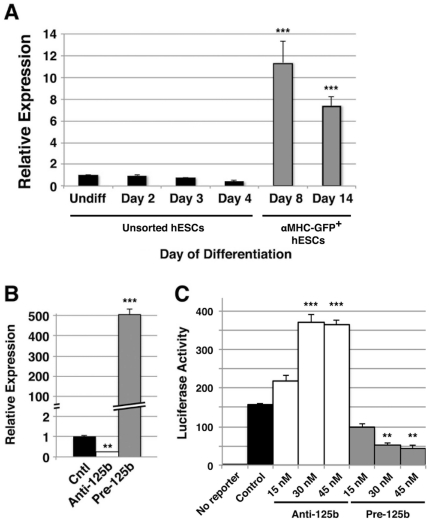
miR-125b expression increases with differentiation in hESCs.
A) Relative expression of endogenous miR-125b in undifferentiated hESCs (Undiff) and hESCs grown in differentiation medium for 2, 3, and 4 days, or sorted αMHC-GFP+ hESCs differentiated for 8 and 14 days (as for
Figure 1
) was assessed by qPCR. A significant increase in miR-125b expression was observed in sorted αMHC-GFP+ hESCs at day 8 and sustained through day 14 of differentiation. Data shown are mean±s.e.m. (N = 3). ***, p<0.001. B) Relative expression of miR-125b in undifferentiated hESC cultures transfected with 30 nM anti-miR-125b inhibitor (anti-125b) or pre-miR-125b (pre-125b), as analyzed by qPCR, showed appropriate down- or up-regulation of miR-125b expression, respectively, compared to untransfected control (Ctl) hESCs. C) Relative binding and activity of miR-125b in undifferentiated hESC cultures transfected with anti-125b and pre-125b, as assessed by luciferase reporter activity, demonstrated appropriate up- and down-regulation of luciferase activity in a dose-dependent manner, respectively, compared to hESCs transfected with luciferase reporter alone (Ctl). Data shown are mean±s.e.m. (N = 3). **, p<0.01; ***, p<0.001.